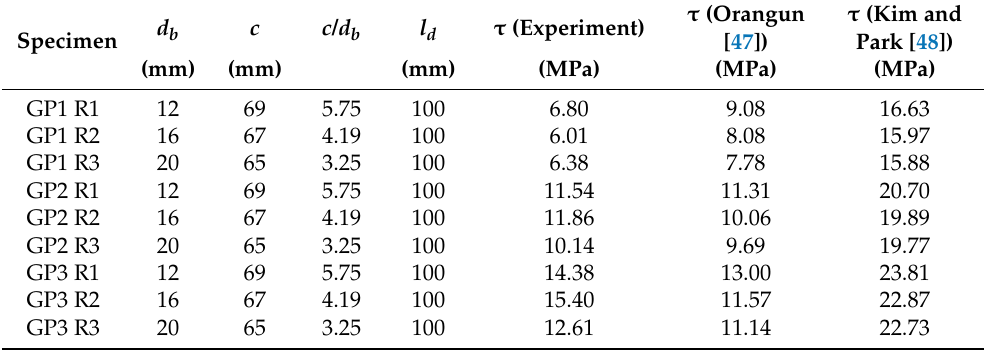
Table 5. Comparison between experimental results and previous